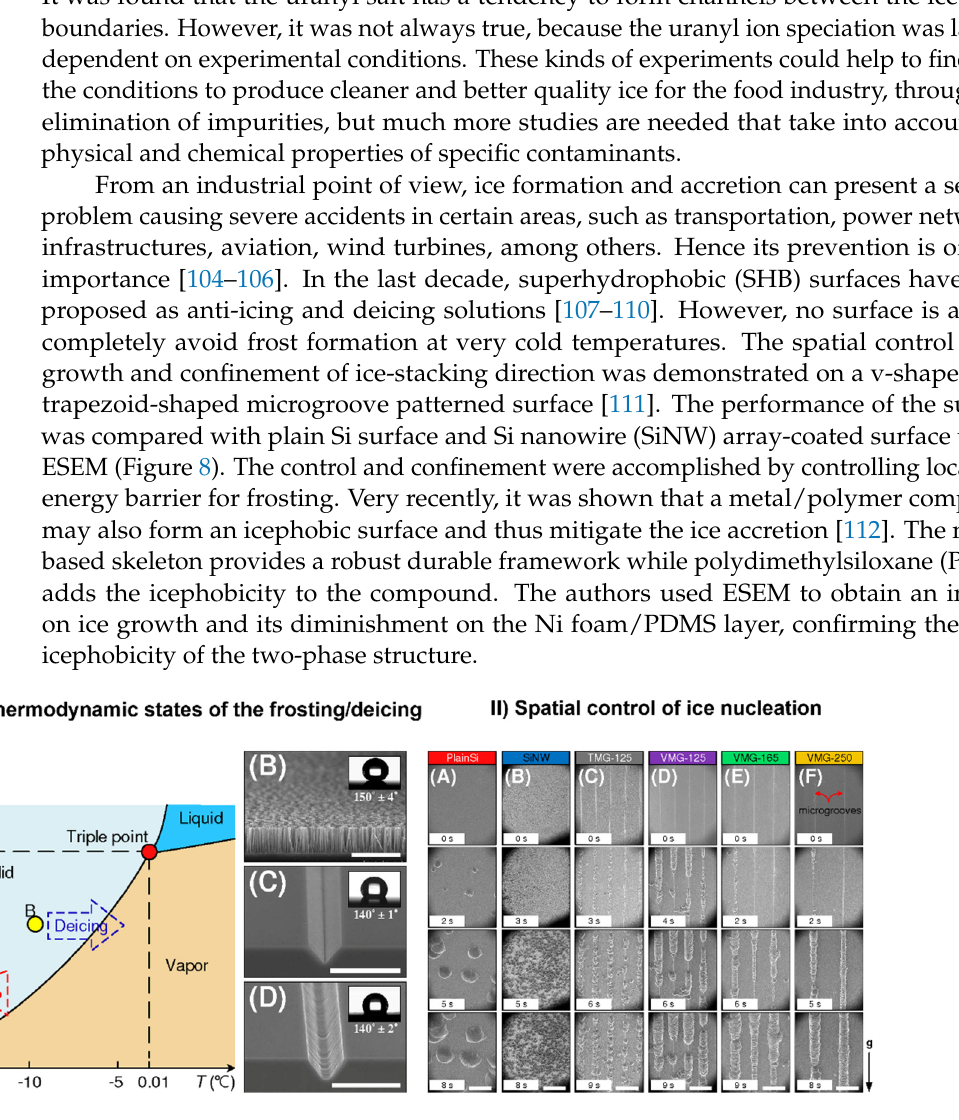
Figure 8. Control of ice nucleation. ( I ): ( A ) The initial thermodynamic states for frosting and deicing processes. Points A and B represent initial states of frosting and defrosting processes, respectively. SEM images of ( B ) the SiNW surface, ( C ) the VMG surface, and ( D ) the TMG surface. The inserts in ( B – D ) are the contact angles on the SiNW, VMG-125, and TMG-125 surfaces. Scale bars in the figure are 15 µm. ( II ): ESEM images of ice nucleation on ( A ) plain silicon, ( B ) SiNW surface, ( C ) TMG surface with a groove spacing of 125 µm, and VMG surfaces with groove spacings of ( D ) 125 µm, ( E ) 165 µm, and ( F ) 250 µm. Scale bars in the figure are 200 µm. Adapted with permission from [111]. Copyright 2017 American Chemical Society.